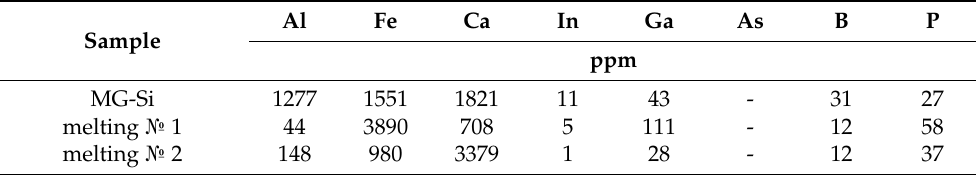
Table 1. Impurity composition of metallurgical Si and Si after slag